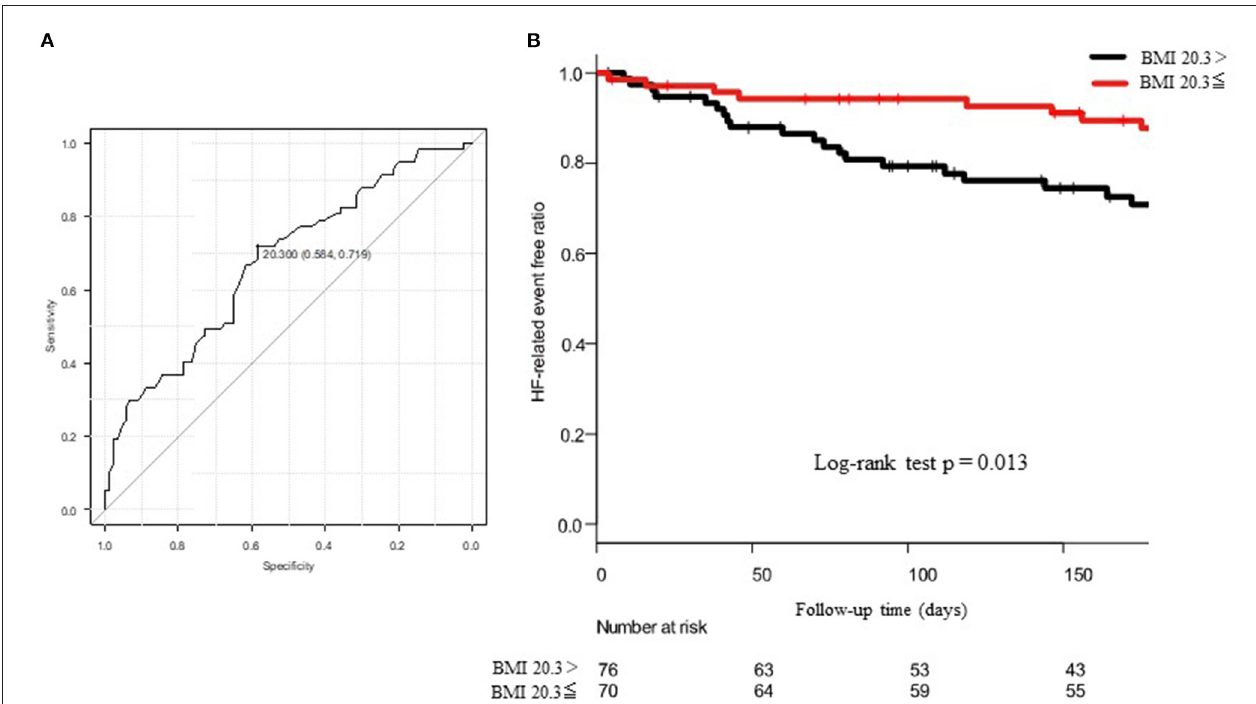
FIGURE 5 | (A) shows the ROC curve to predict the cut-off value of HF-related endpoints using the body mass index (BMI). The AUC was 0.675 and 95% CI was from 0.586 to 0.765. When the cut-off value of BMI was set to 20.3, the sensitivity and the specificity became 58 and 72%, respectively. (B) shows the Kaplan–Meier curve to evaluate the cumulative incidences of HF-related endpoints. The log-rank test revealed a p -value of